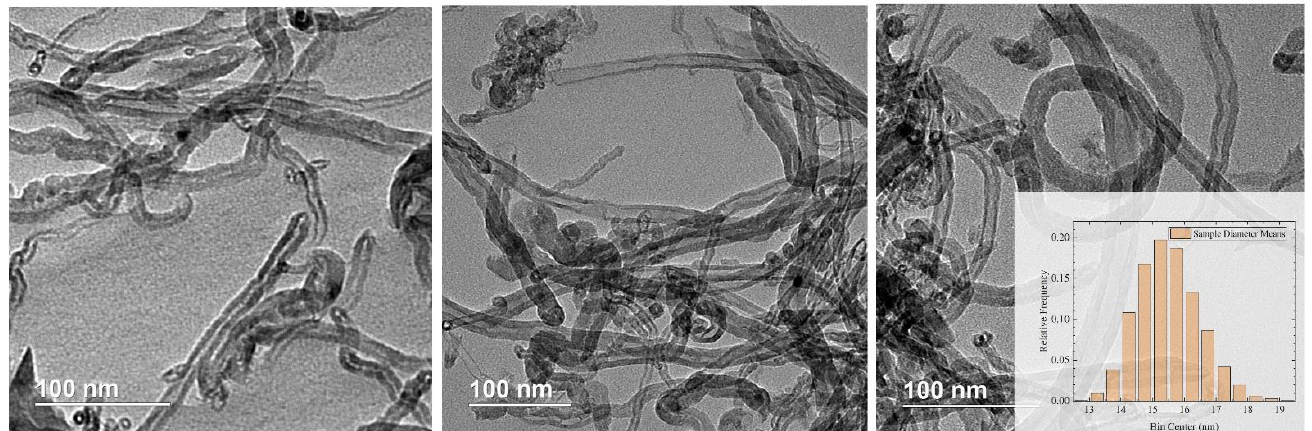
Figure 15. Transmission electron microscope images of multiwall nanotubes used to make electrodes. Inset shows the CNT diameter distribution as determined by statistical bootstrapping from the nanotubes in the images.